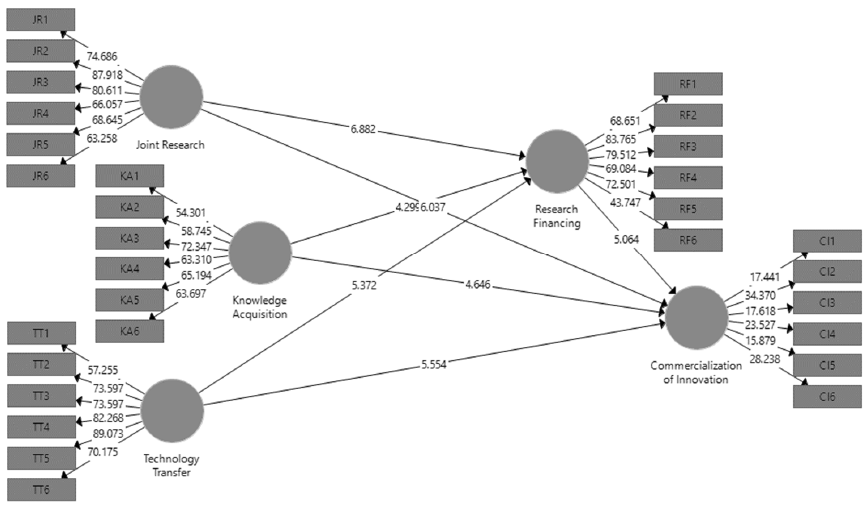
Fig. 2. Bootstrapping's